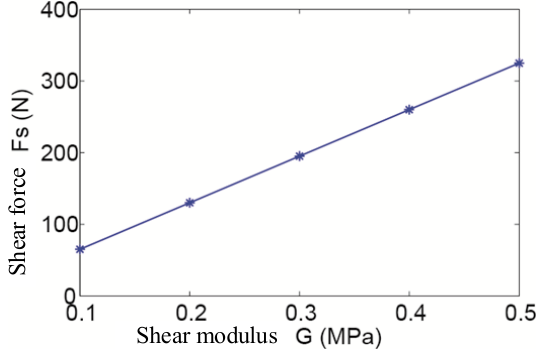
Figure 13. Influence of the shear modulus on shear force.